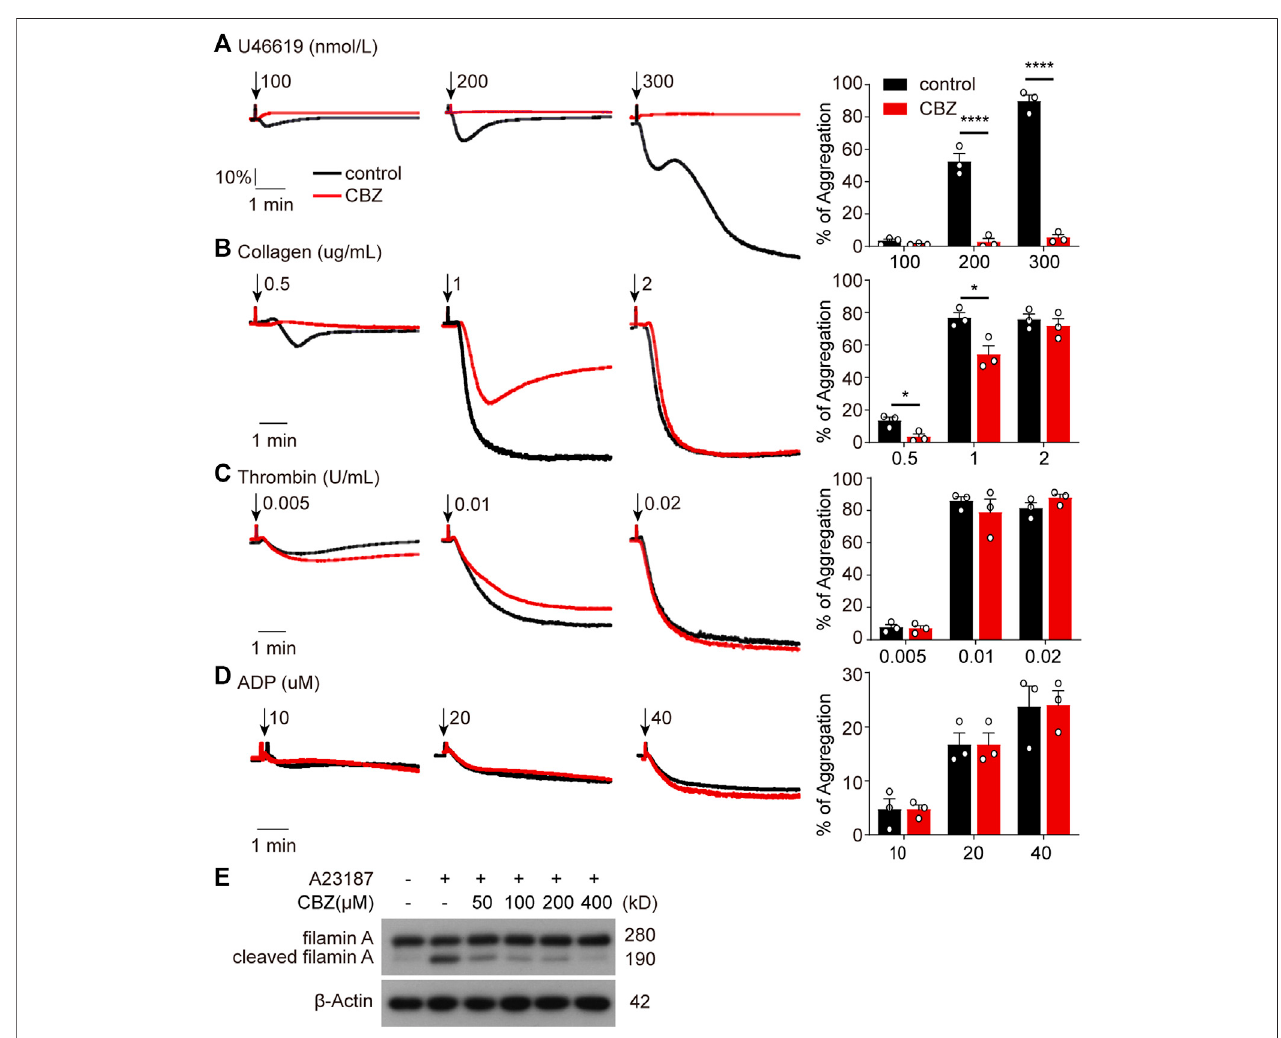
FIGURE 6 | CBZ initiated Akt activation is not involved in platelet hyperactivity through simultaneous calpain inhibition. (A – D) Human Washed platelets (A – C) or PRP (D) were incubated with CBZ (100 μ M) or vehicle (DMSO) at 37 ° C for 5 min. The pretreated platelets or PRP were stimulated with different concentrations of U46619 (A) , collagen (B) , thrombin (C) , and ADP (D) at 37 ° C under constant stirring. Platelets aggregation was monitored using a CHRONO-LOG aggregometer. Histograms of maximal platelets aggregation under the indicated conditions are shown as mean ± SD of three independent experiments; n (cid:2) 3. * p < 0.05, **** p < 0.0001 versus control group, two-way ANOVA prior to Bonferroni post hoc test. (E) Washed human platelets were incubated with indicated concentrations of CBZ or vehicle control at 37 ° C for 30 min followed by 1 μ M A23187 treatment at RT for 5 min. Total and cleaved fi lamin A were analyzed by Western blot analysis with anti- fi lamin A